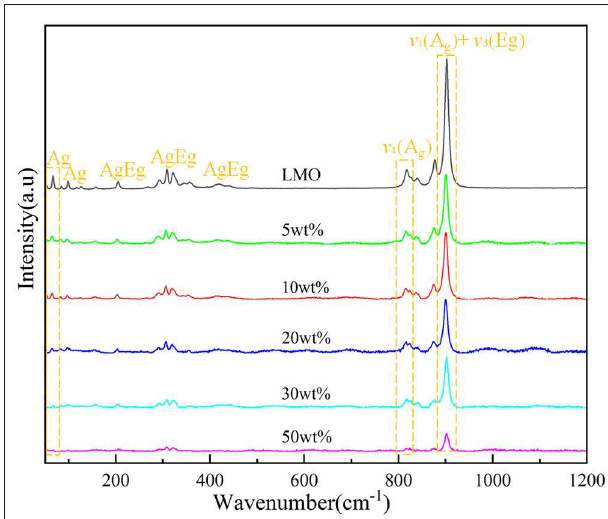
FIGURE 3 | Raman spectra of (1-x) LMO-xMSO composite ceramics.